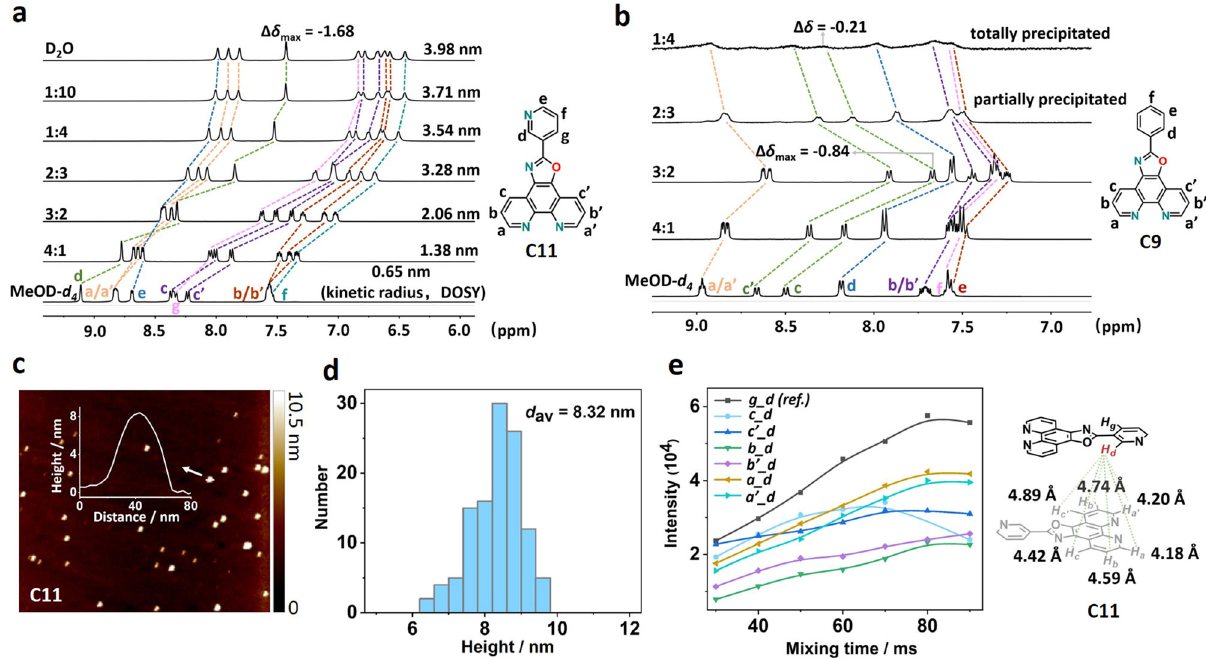
Fig. 2 Investigation of self-assembly behaviors in aqueous solution. a Stacked 1 H NMR spectra of C11 in MeOD- d 4 /D 2 O mixture with variable volume ratios (each proton was assigned and labeled along with different solvent ratios, the kinetic radii of ensembles under each condition were measured by DOSY spectra and calculated by Stokes-Einstein equation). b Stacked 1 H NMR spectra of analogous C9 in MeOD- d 4 /D 2 O mixture with variable volume ratios. c , AFM analysis of C11 in aqueous condition (a height pro fi le of selected nanoparticle was inserted). d Statistical distribution of C11 -based nanoparticle number versus size. e Left: NOE build-up curves for C11 in D 2 O, right: calculated intermolecular adjacent proton distances with peak d derived from the NOE growth rate analysis using peak g-d correlation as internal